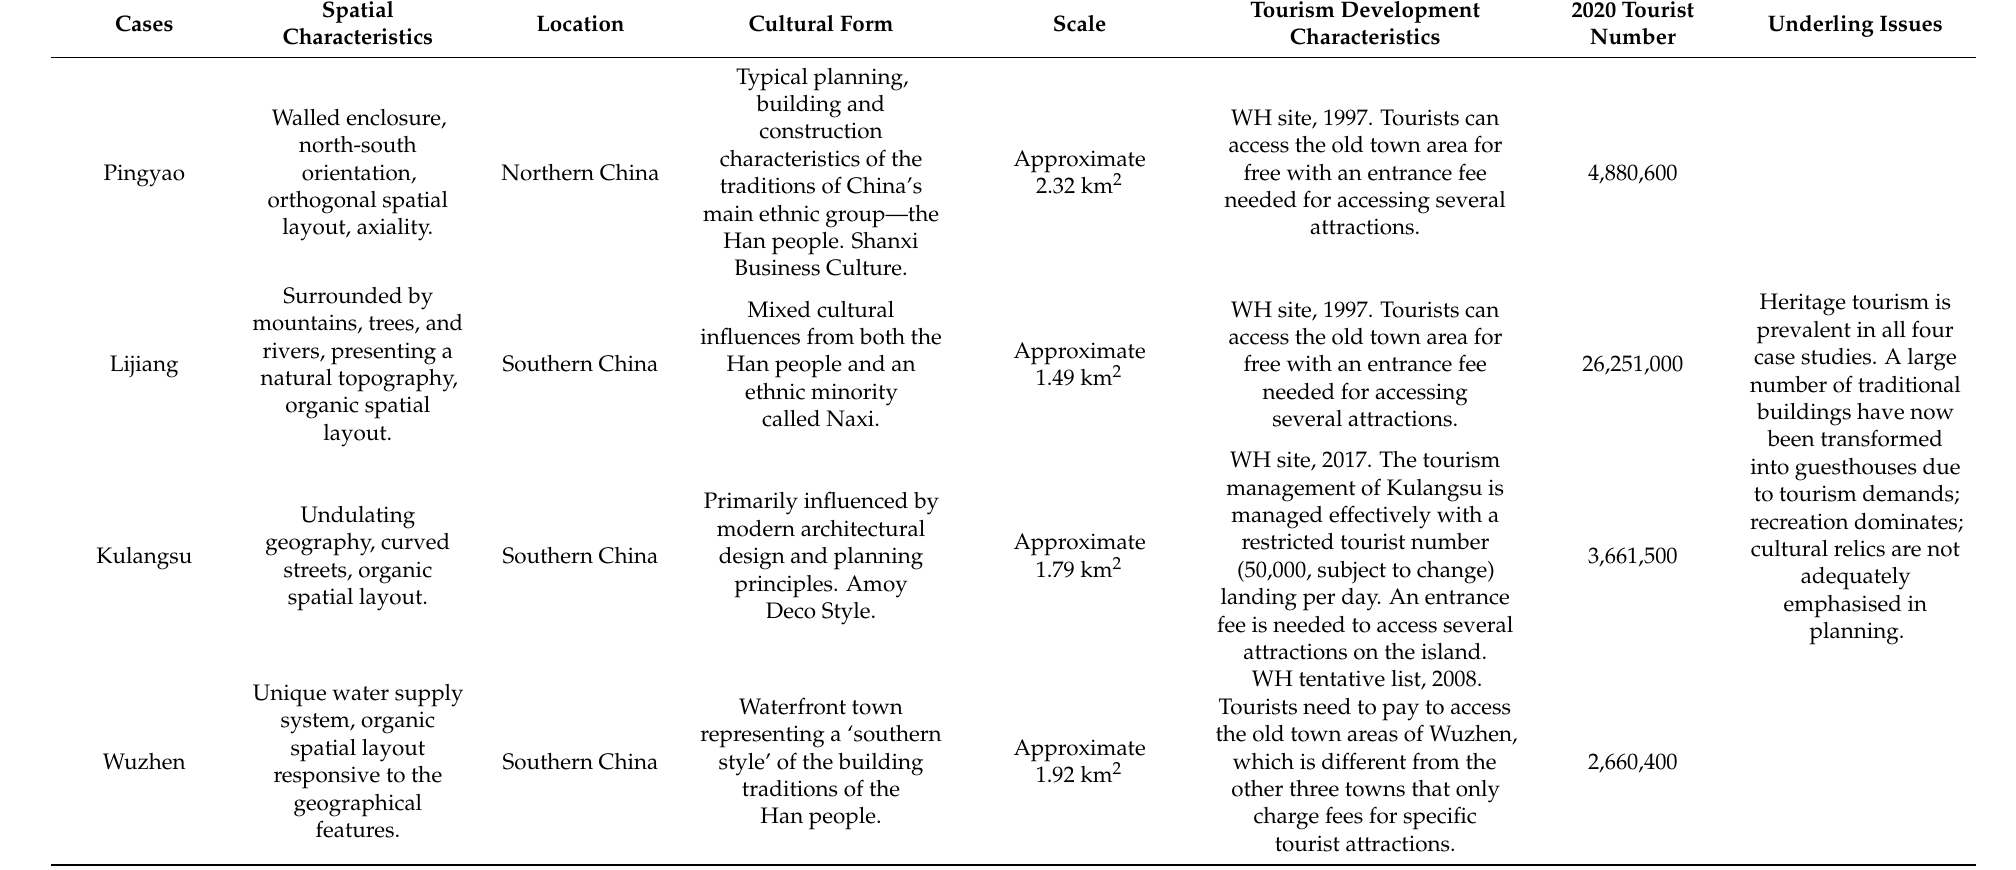
Table 1. A comparison of the four case